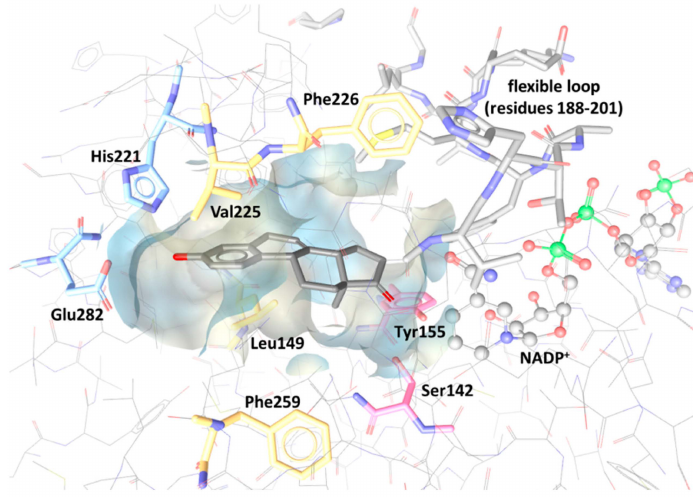
Figure 12. Shape binding site of 17 β -HSD1 with equilin as co-crystallized ligand, key residues, a flexible loop and the cofactor NADP + (PDB